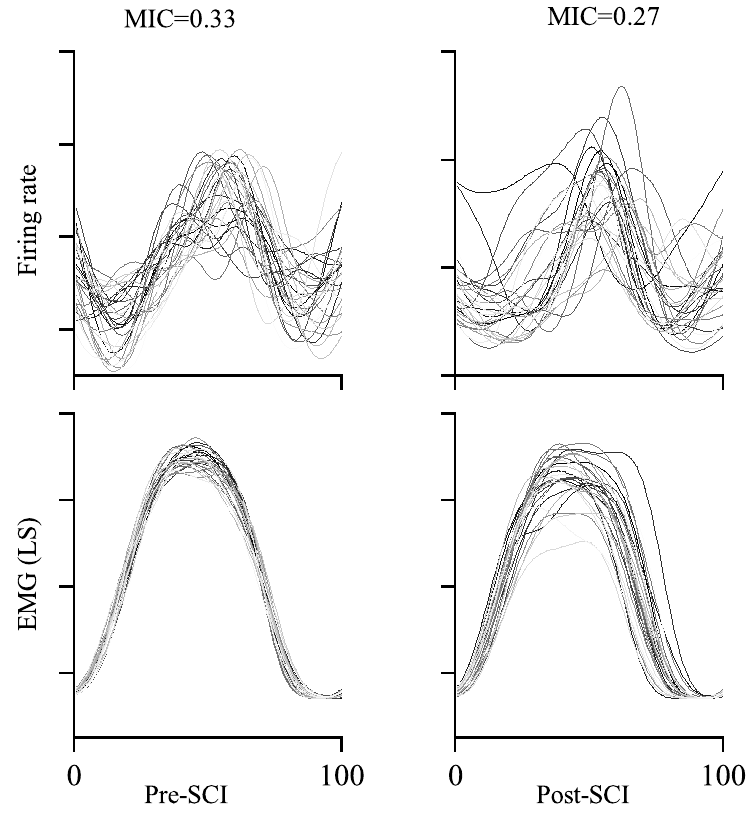
Figure 7. Examples of the MIC values between neural response and muscle activity. Each line represents neural response ( top ) and muscle activity ( bottom ) in a single walking